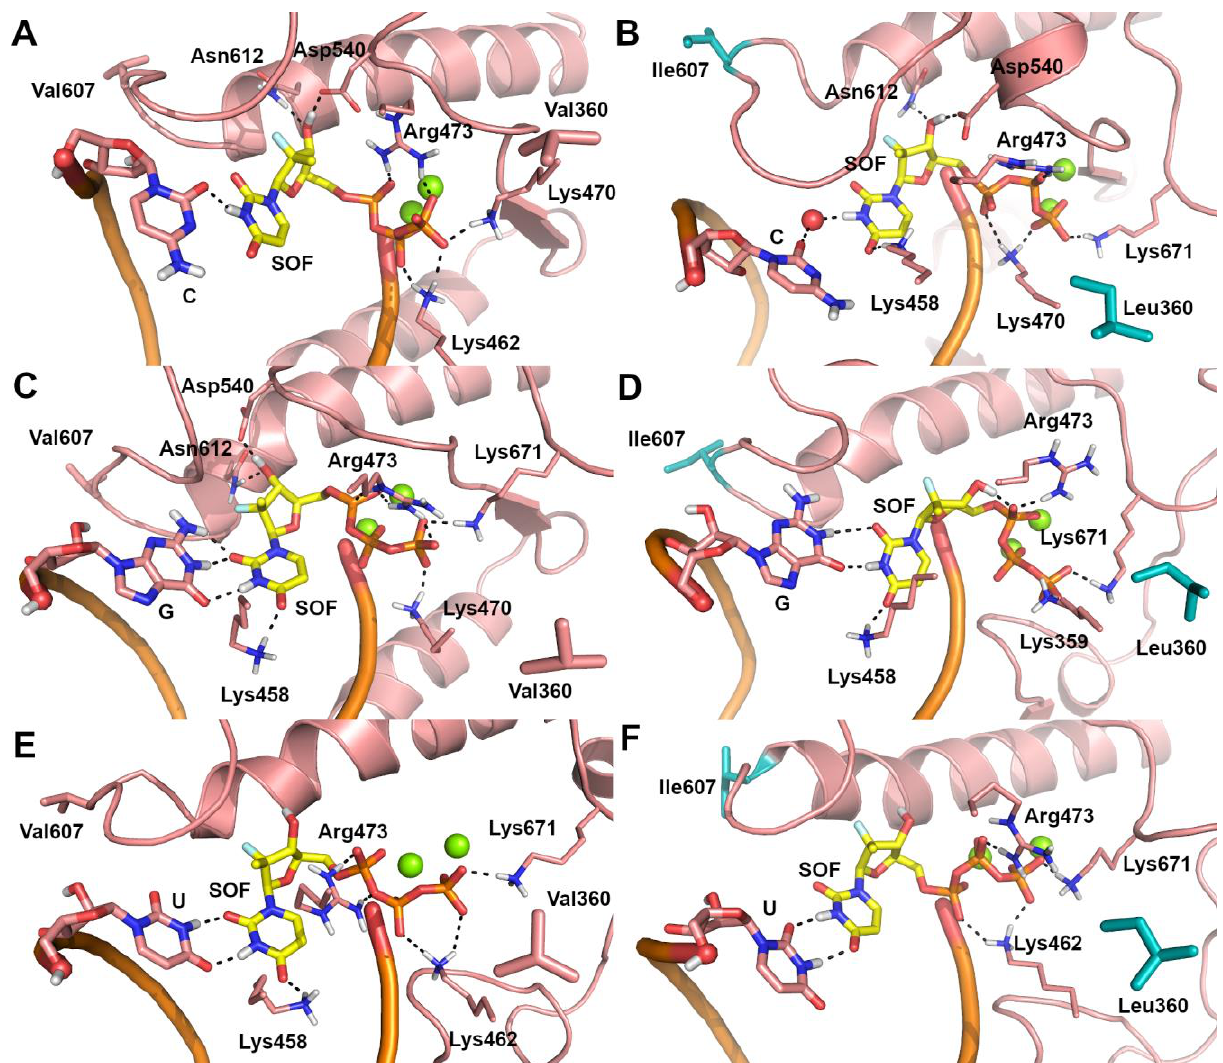
Figure 2. Predicted binding poses of sofosbuvir (SOF) (yellow sticks) within the catalytic site of ZIKV RdRp in the representative structures extrapolated from MD trajectories. ( A ) C-SOF-WT ZIKV RdRp system. ( B ) C-SOF-V360L/V607I mutant ZIKV RdRp system. ( C ) G-SOF-WT ZIKV RdRp system. ( D ) G-SOF-V360L/V607I mutant ZIKV RdRp system. ( E ) U-SOF-WT ZIKV RdRp system. ( F ) U-SOF-V360L/V607I mutant ZIKV RdRp system. Polar contacts are highlighted by black dashed lines. Residues involved in polar and non polar interactions with sofosbuvir are shown as sticks and are labelled. The opposite C, G, and U from the RNA template are shown as sticks. Mg 2+ ions are shown as green spheres. Mutated residues are highlighted by cyan sticks. Table 3. Molecular Mechanics Generalized Born Surface Area (MM-GBSA) theoretical affinity of sofosbuvir and UTP to